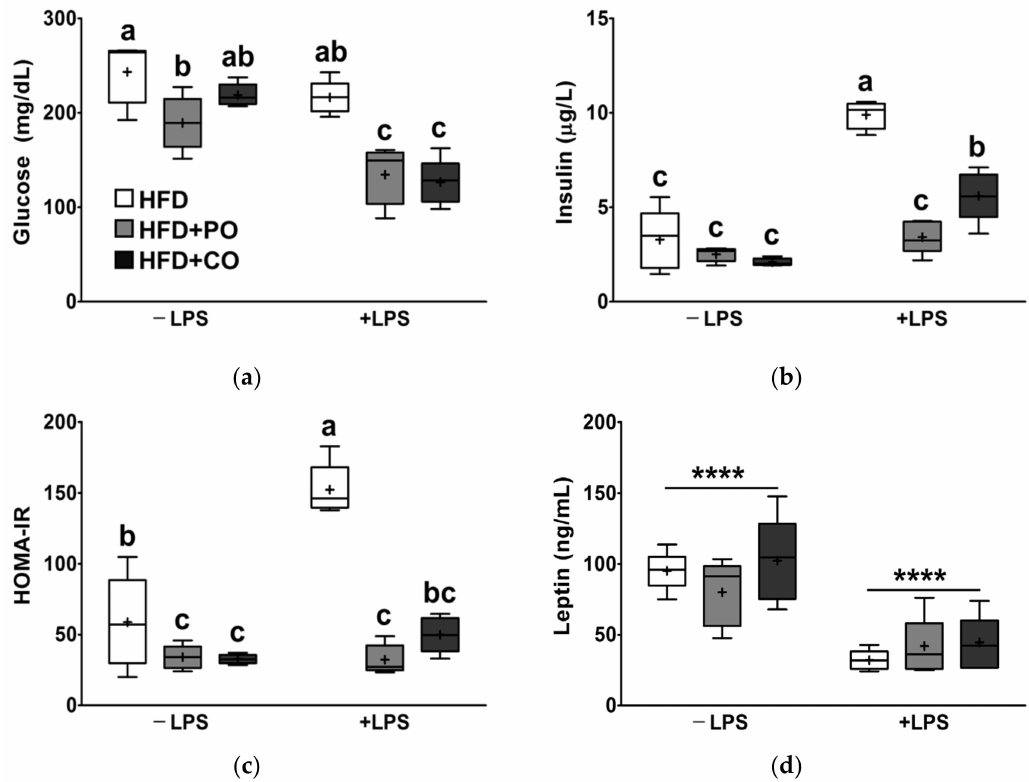
Figure 3. Effects of partial replacement of dietary fat with PO or CO and LPS stimulation on serum glucose, insulin, and leptin levels. Five-week-old male Sprague-Dawley rats were fed either the HFD, HFD + PO, or HFD + CO for 12 weeks and then treated with PBS or LPS (5 mg/kg) for 24 h ( n = 8 per group). ( a ) Glucose level; ( b ) insulin level; ( c ) homeostasis model assessment-estimated insulin resistance (HOMA-IR); ( d ) leptin level. Data were analyzed using two-way ANOVA and Tukey’s multiple comparisons post hoc test for multiple comparisons. Means with different letters indicate significant differences at p < 0.05. Asterisk indicates a significant main effect for LPS (**** p < 0.0001). LPS, lipopolysaccharide; PBS, phosphate-buffered